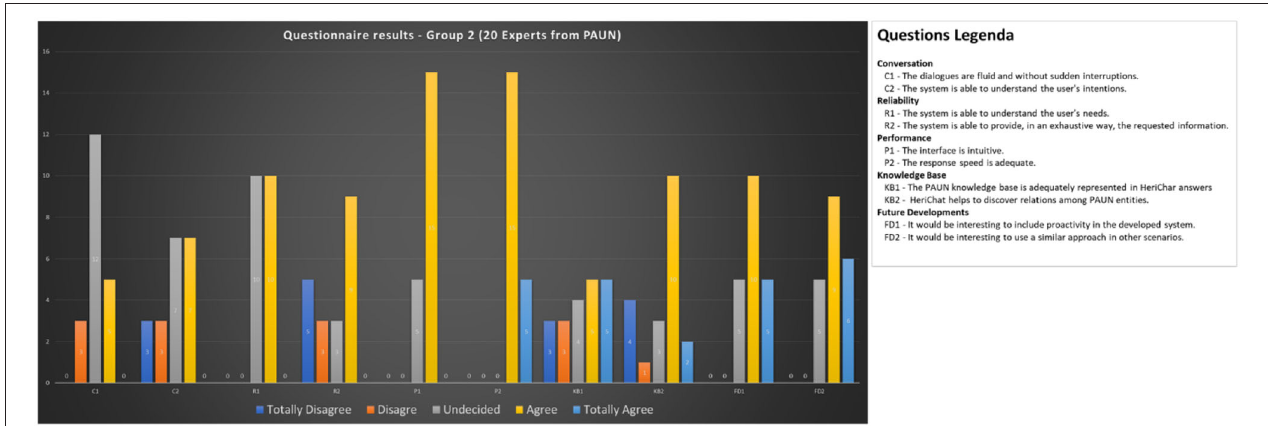
FIGURE 11 | Questionnaire results for Group 2